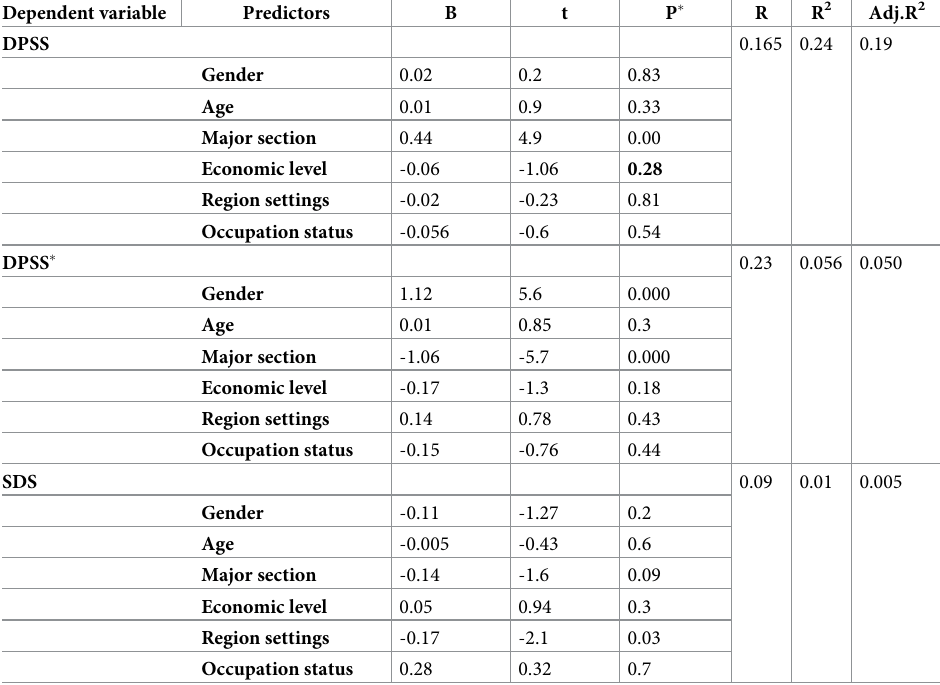
Table 5. Predictors for stigma and social distance by multiple linear regression analysis.